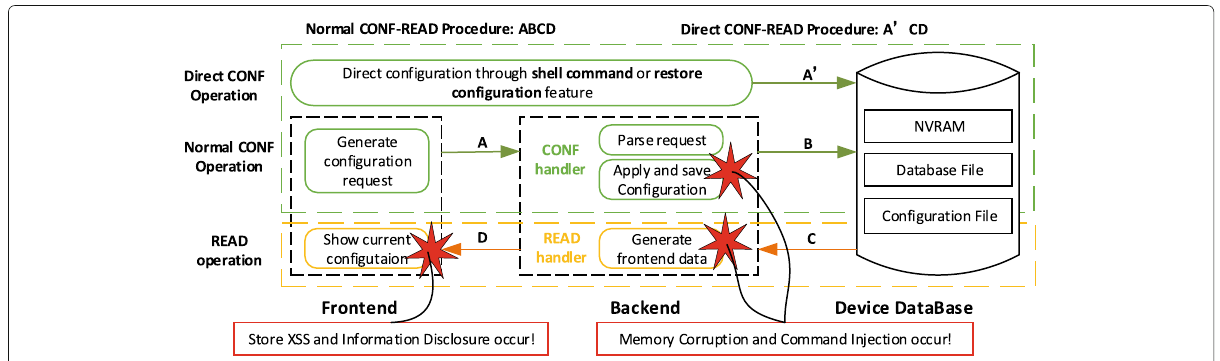
Fig. 2 Typical workflow in term of CONF-READ model